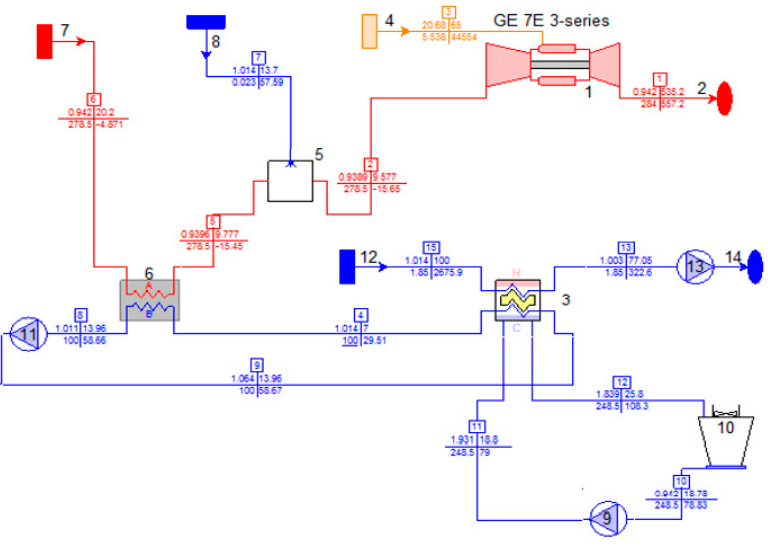
Figure 9. Gas turbine with hybrid absorption refrigeration evaporative inlet cooling.